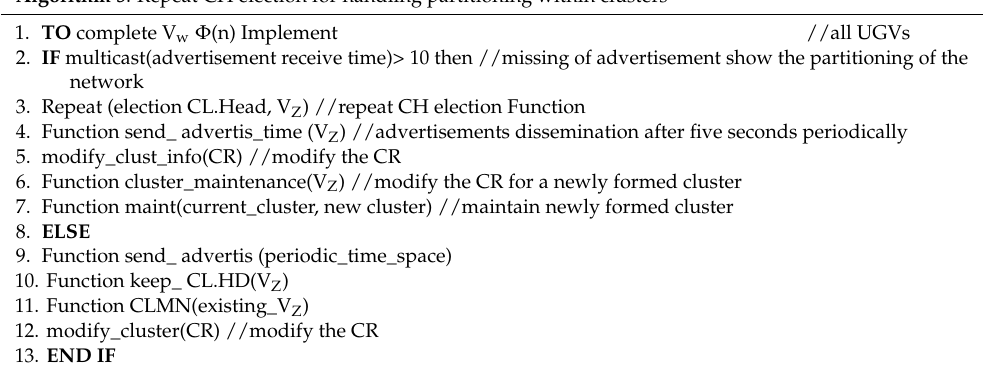
Algorithm 5 . Repeat CH election for handling partitioning within clusters